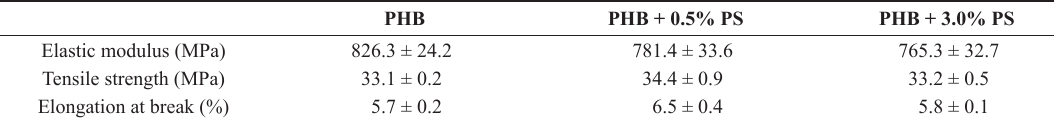
Table 2. Mechanical properties of PHB and PHB/PS blends.